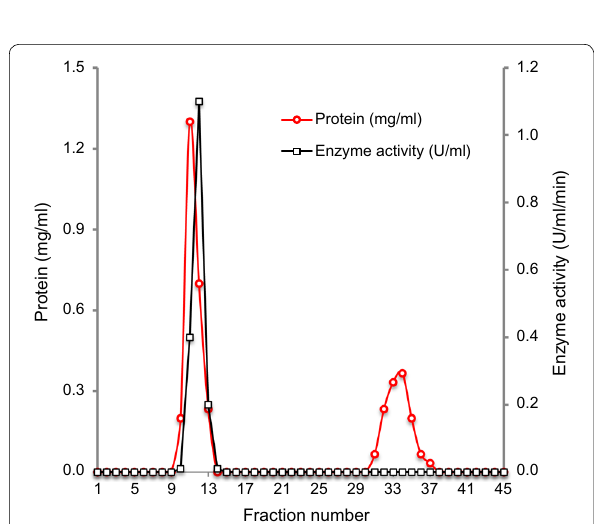
Fig. 2 Elution profile of lignin peroxidase by Biogel P-150 gel filtra- tion chromatography